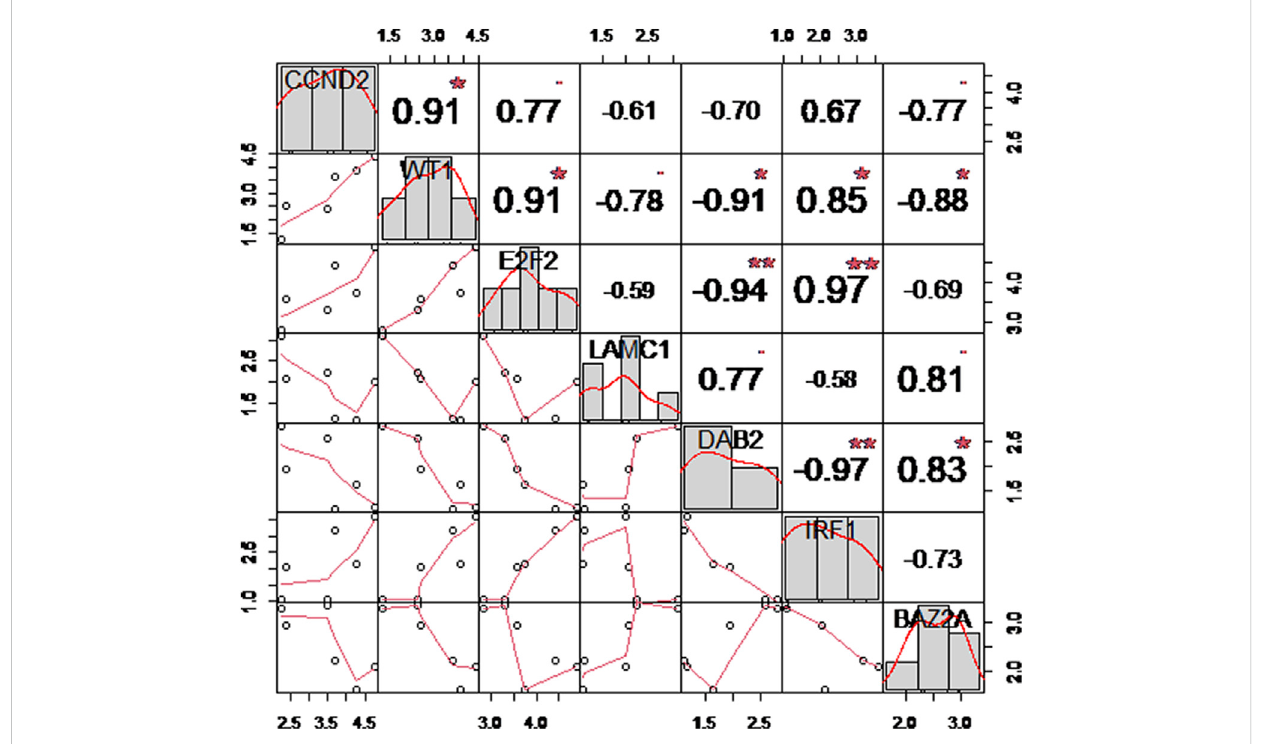
FIGURE 7 Correlation matrix analysis of robust hub genes. The distribution plot is shown on the diagonal; the lower left shows a bivariate scatterplot with a fi tted line; and the upper right shows the correlation coef fi cient and signi fi cance